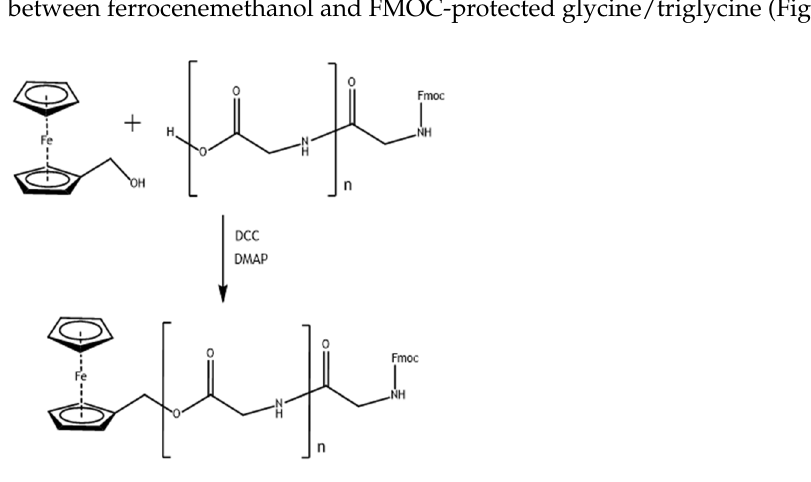
Figure 4. Synthesis of ferrocenemethanol esters by the carbodiimide method.